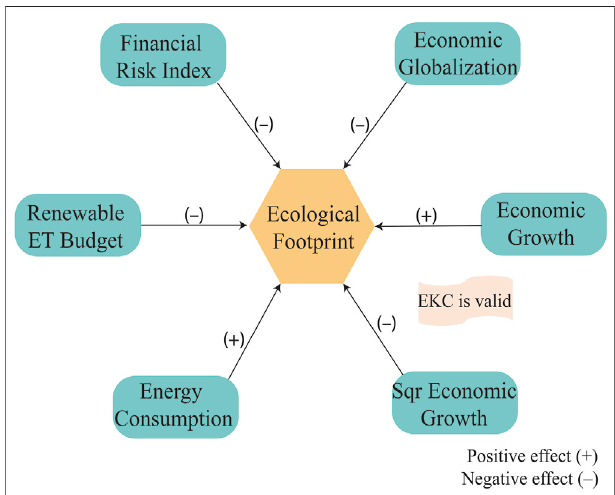
FIGURE5| Visualrepresentationoflong-runresultsbasedonCS-ARDL FMOLS, and DOLS.